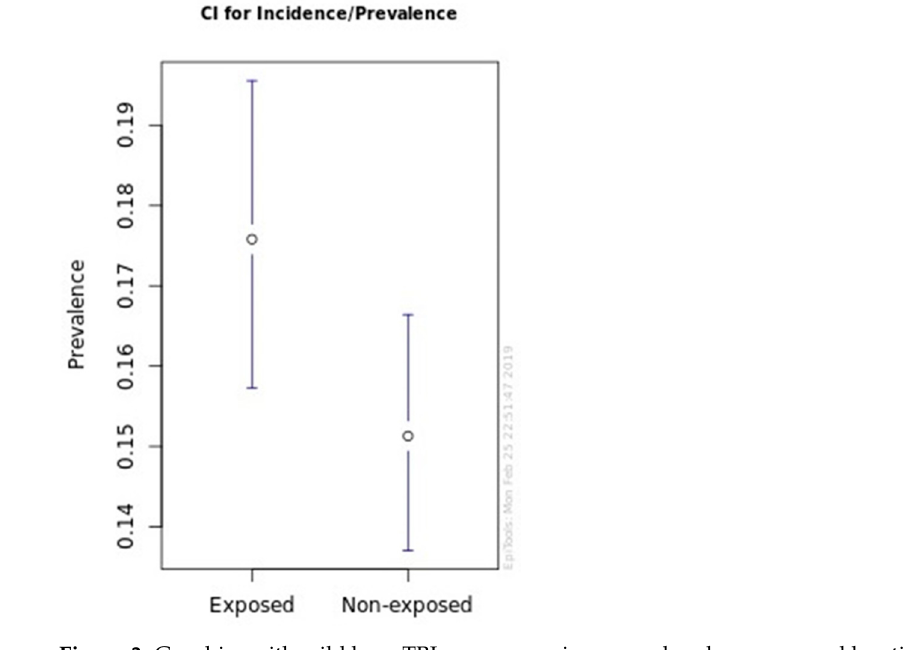
Figure 3. Graphics with wild boar TBL occurrence in exposed and non-exposed hunting seasons.